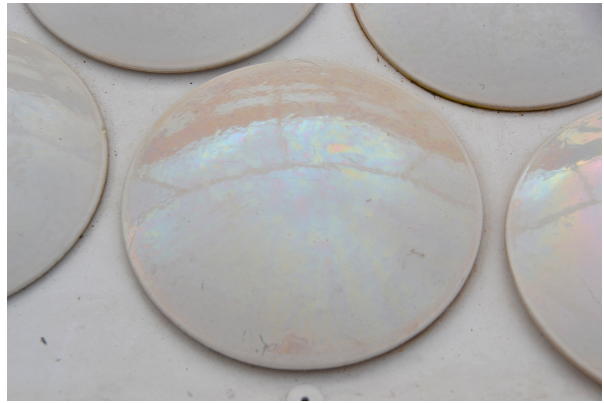
Figure 6. Enclosure ceramic tile with an iridescent and reflected light effect. Photograph: Fernando Echarri.